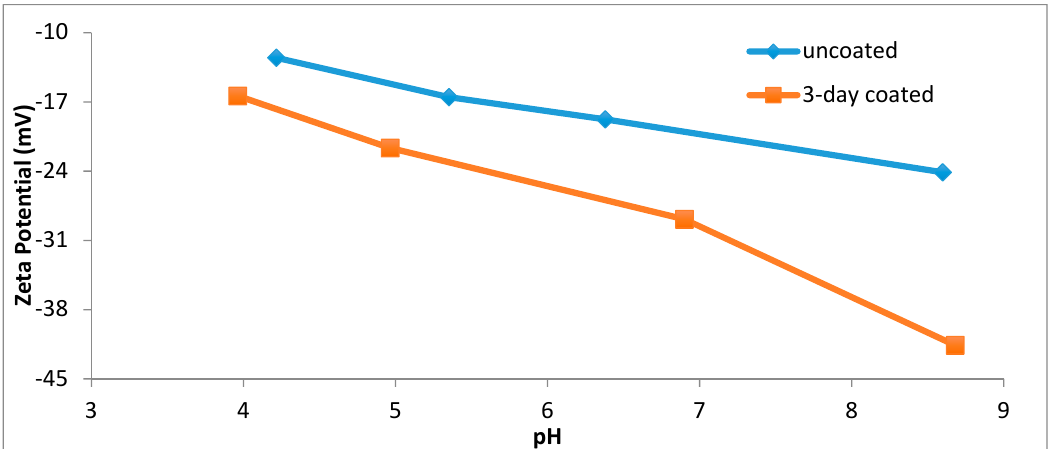
Figure 7. The zeta potentials of the uncoated and three-day coated membranes. Symbols represent the average of two measurements made at each pH value for each membrane sample.